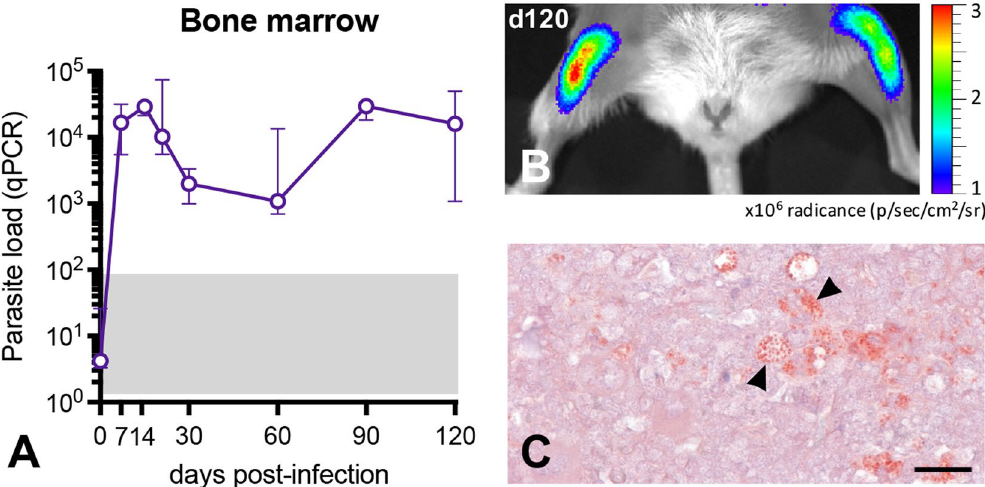
Figure 2. Parasite detection in the bone marrow of BALB/c mice infected with Leishmania donovani . ( A ) Kinetics of the parasite load in the bone marrow detected by RT-qPCR. The grey area corresponds to background signals in PCR. Data are represented as median and the interquartile range. ( B ) Representative image illustrating the 2D-bioluminescence analysis of the parasite detection in the femoral bone marrow at day 120 post infection. ( C ) Immunohistochemical detection of parasite amastigotes (arrowhead) in the femoral bone marrow. Immunoperoxidase, scale bar = 100 μ